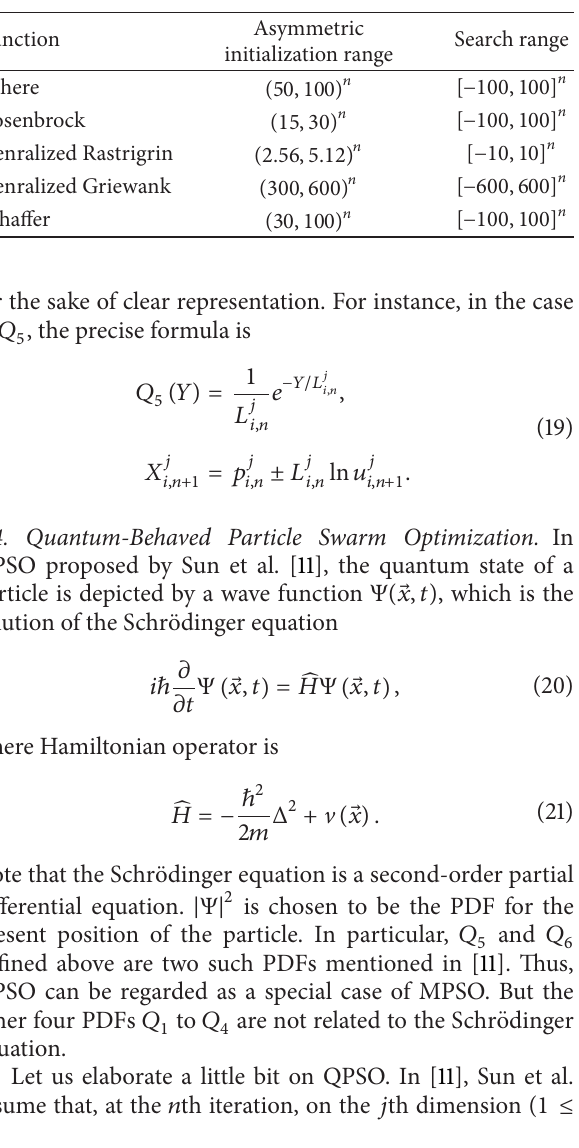
Figure 6: Figure of the probability density function 𝑄 6 . Table 1: Asymmetric initialization and search